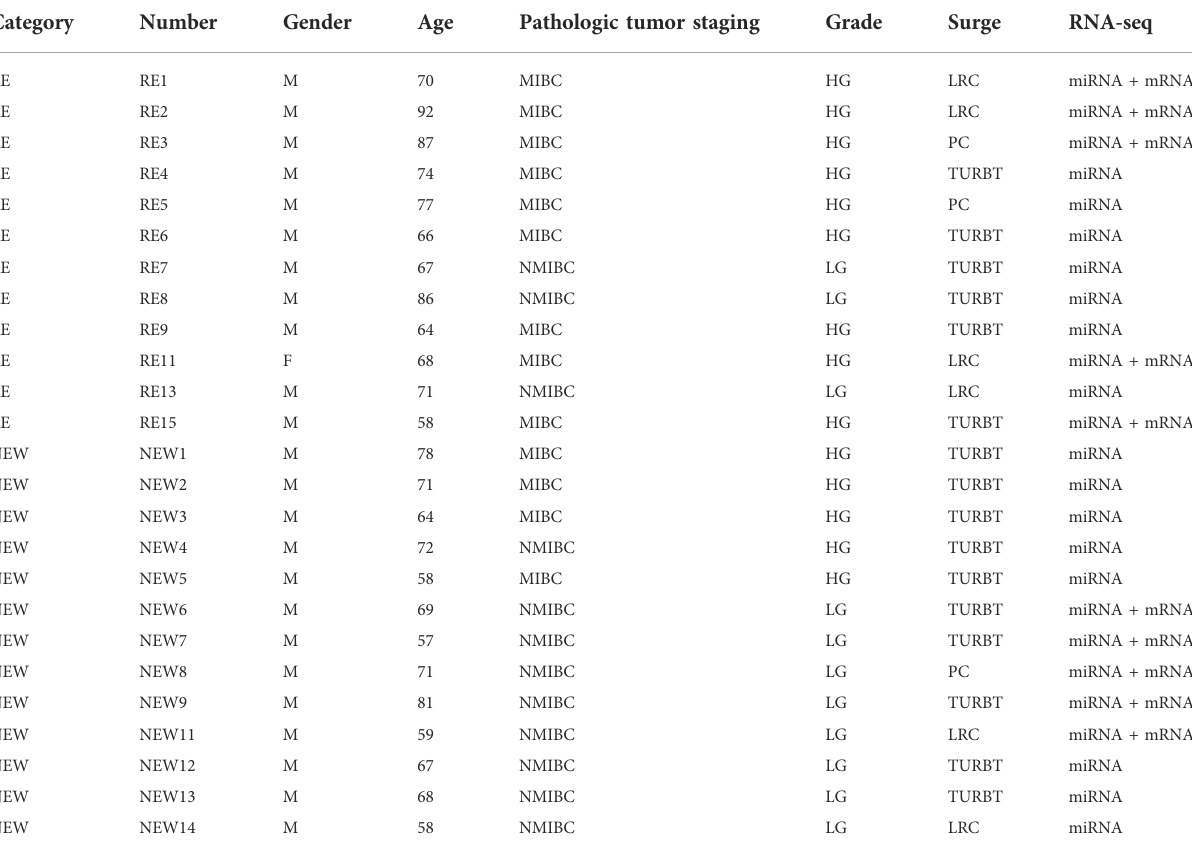
TABLE 1 Patients information. Patients information Category Number Pathologic tumor